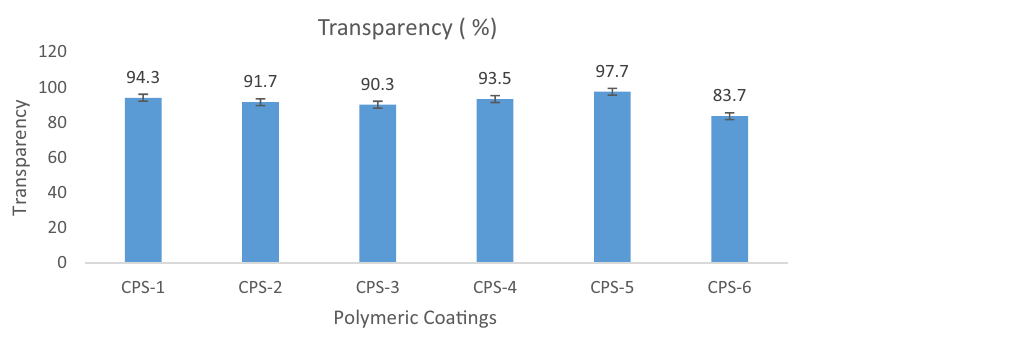
Figure 14 above showing the self-cleaning activity of coated glass and uncoated glass against Mud, solution of methyl red, Methyl orange and K 2 Cr 2 O 7 . All the applied liquids do not adhere to the polymeric coated surface and the liquids are removed by a sliding action. There are no dirt lines left on the coated surface showing excellent self-cleaning action. Further the lower surface tension of coating is one of the key factors for the average transmis- sion of light before and after prolonged outdoor exposure. The suspension of applied liquids on coating surface reveals lower surface tension. In contrast to coated glass, uncoated glass failed to remove the applied liquid even at tilting angle of approximately 60°. Which cause lower transmission and thus transparency is not achieved nor self-cleaning due to spread of liquids and dirt on surface due to higher adhesion with surface of uncoated glass.